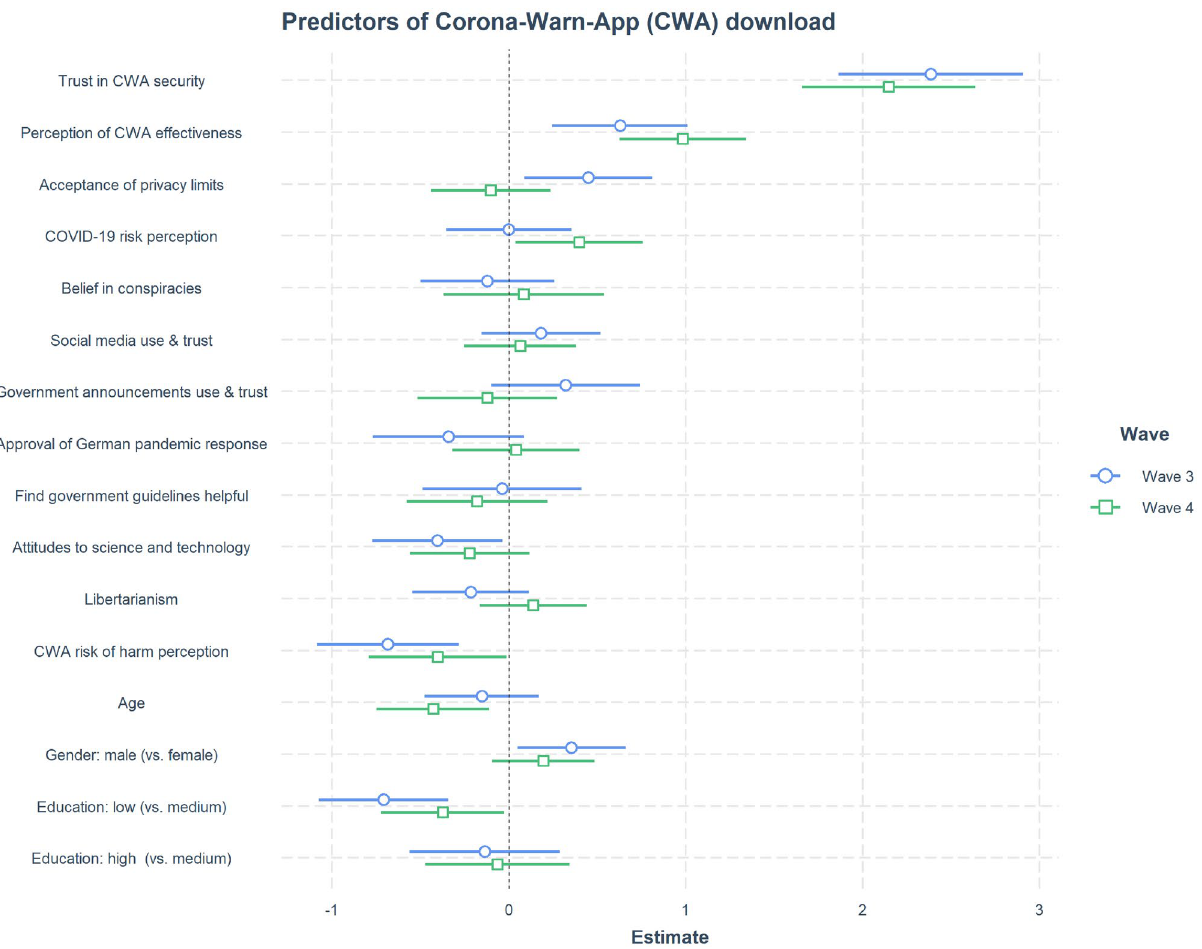
Figure 10. Logistic regression models predicting Corona-Warn-App download in Waves 3 and 4. Dependent variable: downloaded the app (yes/no). Coefficients: measures from the survey (e.g., combined score for trust in CWA security; combined score for conspiracy beliefs; see Supplementary Table B10). Horizontal point ranges show point estimates and 95% confidence intervals for each predictor. Education was dummy coded with the reference level “medium,” yielding two coefficients: low (vs. medium) and high (vs. medium) education. Following 30 , we standardized all continuous variables by two standard deviations (SD) and mean centered the binary gender variable. This way a 2-SD change in a continuous predictor variable is approximately equivalent to a change of category in a roughly balanced binary predictor variable (e.g., gender). In a logistic regression model, a slope reflects the relative change in log odds (while keeping all other predictors at their average values). Supplementary Table A6 summarizes the regression results for these two models. Supplementary Figures A6 and A7 display Pearson correlations for all variables in the regression model. Supplementary Figure A8 provides an alternative arrangement of the same results, where the respective model for each wave is shown in a separate